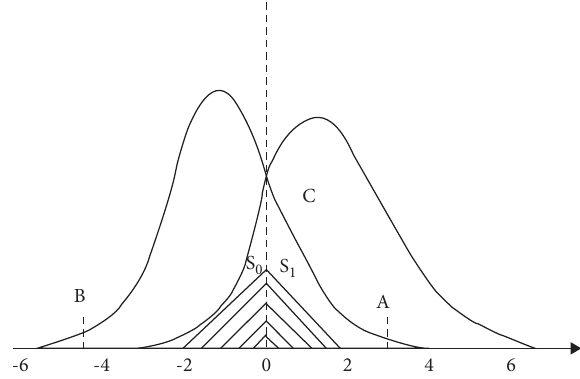
Figure 2: Schematic diagram of the probability density distribution function of the test